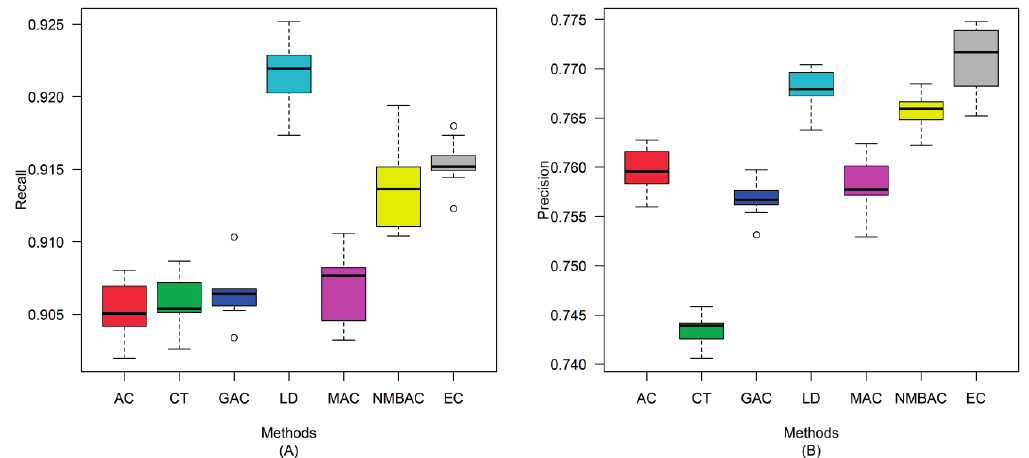
Figure 17. Average recall and precision of different methods on the Silver Human dataset with five-fold cross-validation. ( A ) Recall; ( B ) Precision.